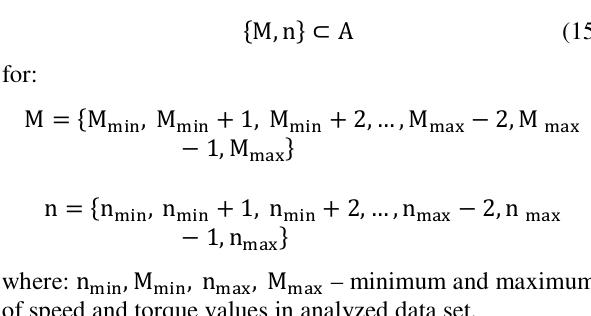
Fig. 2. Interpretation of two static state conditions for engine speed: blue Fig. 3. Example of points selection corresponding to the static state; lines – limit of 2% variation, green line – derivative of the approximation assumed minimum static state duration (T) 2 seconds function